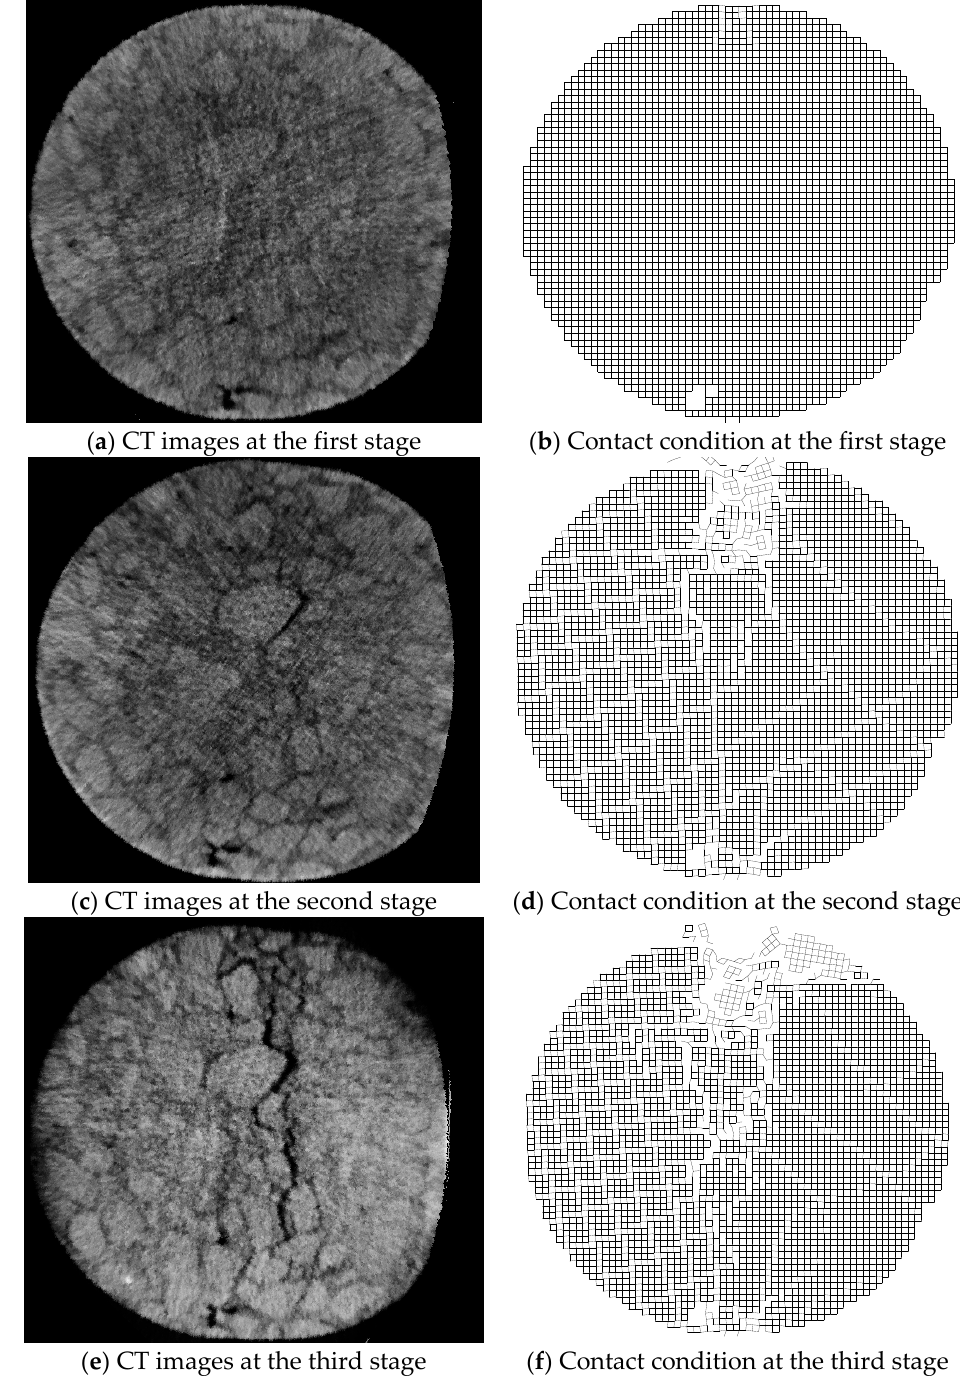
Figure 12. Cracks in the simulation test and laboratory test.